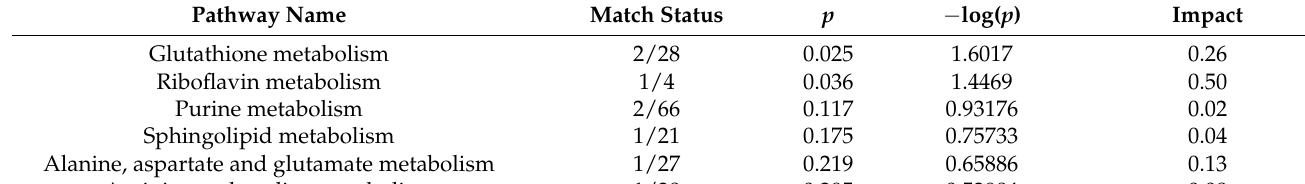
Table 1. Pathway enrichment results for differential expressed metabolites (Impact > 0).